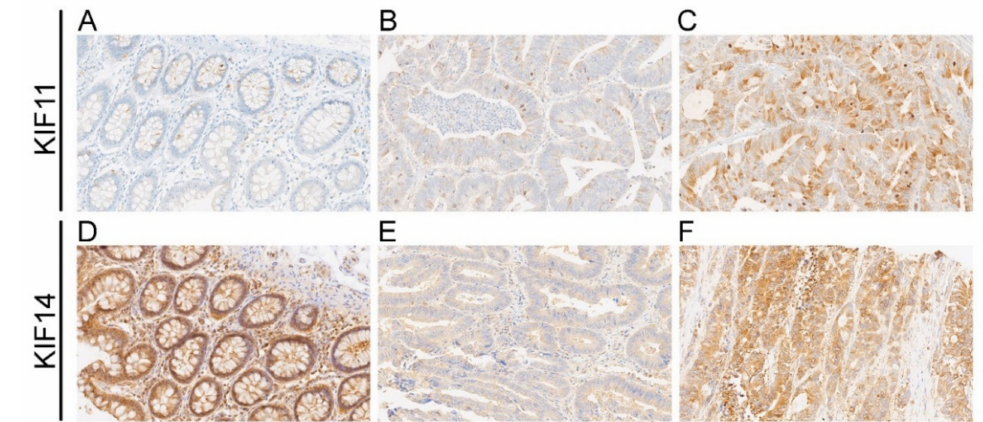
Figure 1. Representative photographs showing immunohistochemical expression of KIF11 ( A – C ) and KIF14 ( D – F ) in colorectal cancer (CRC) and adjacent tissue (control). KIF11 staining in control tissue ( A ); weak staining ( B ) and strong staining ( C ) for KIF11 in CRC; KIF14 staining in control tissue ( D ); weak staining ( E ) and strong staining ( F ) for KIF11 in CRC. Original magnification 20 ×